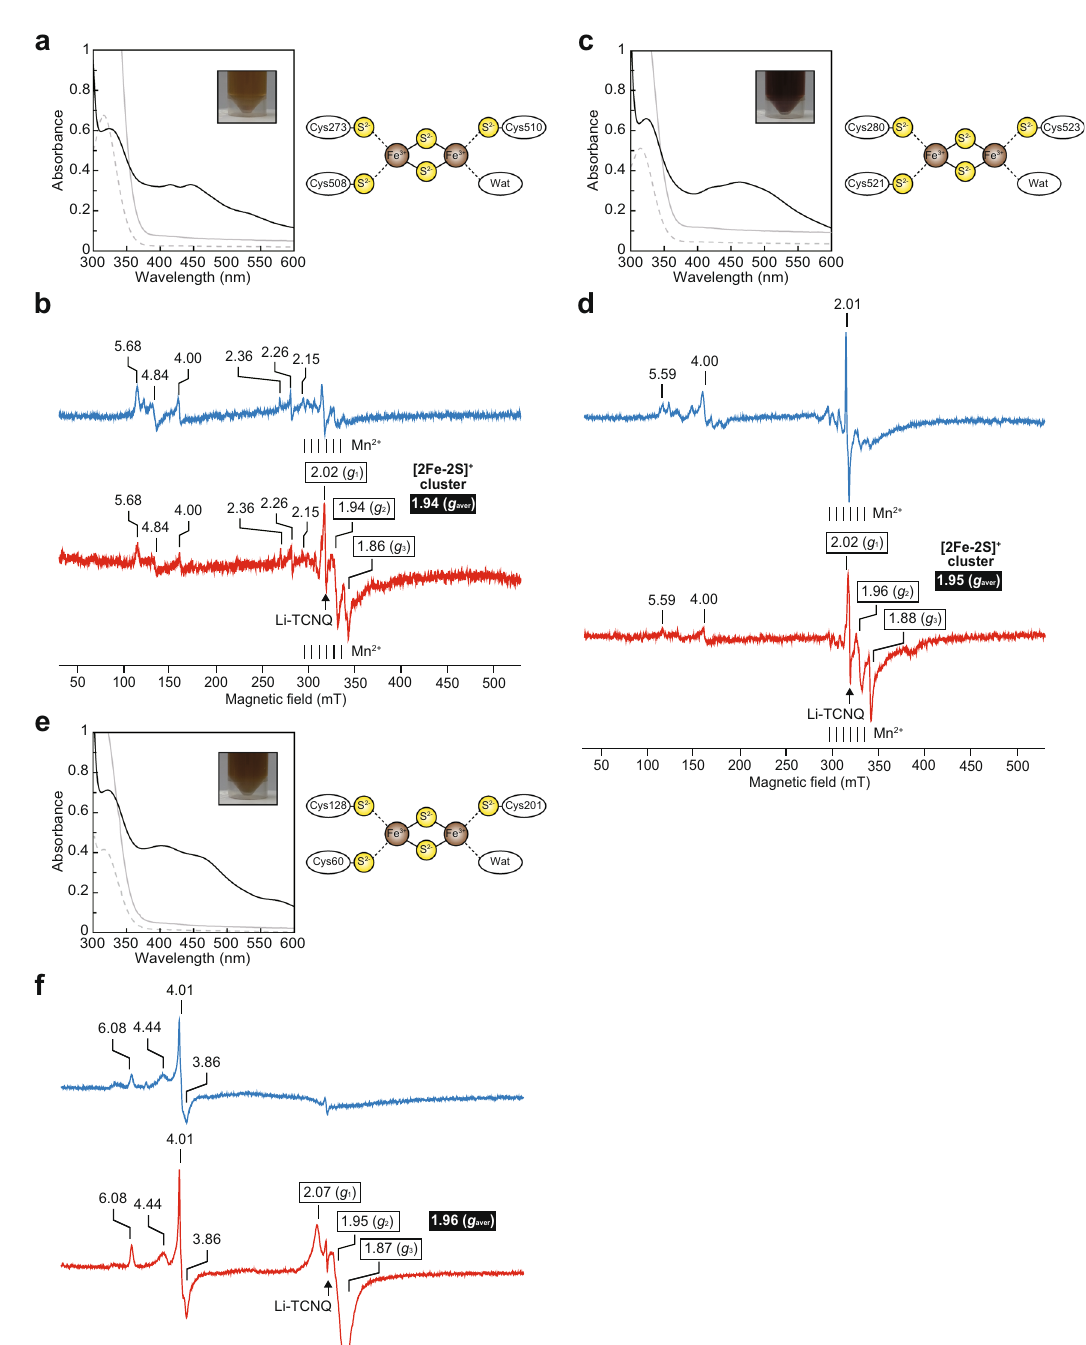
Fig. 5 UV and EPR spectroscopy. UV visible absorption spectra of AtAcnX ( a ), PsAcnX ( c ), and AraC ( e ) as isolated (black) and following reduction with Na 2 S 2 O 4 (gray). A fi vefold diluted sample of the latter is shown as a dashed line. Inset photographs indicate the puri fi ed recombinant enzyme (~40 mg/ml). Light panels are schematic descriptions of the [2Fe-2S] cluster. EPR spectra of AtAcnX ( b ), PsAcnX ( d ), and AraC ( f ) as isolated (blue) and following reduction with Na 2 S 2 O 4 (red) at 20 K. The numbers in boxes are the g values of prominent features for the [2Fe-2S] cluster. White letters in black boxes are the average g values of g 1 , g 2 , and g 3